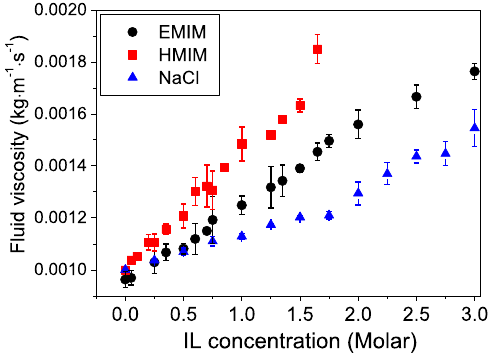
Figure 1. The viscosity of the aqueous solutions of ILs, i.e., EMIM and HMIM, and NaCl, as a function of their concentration.